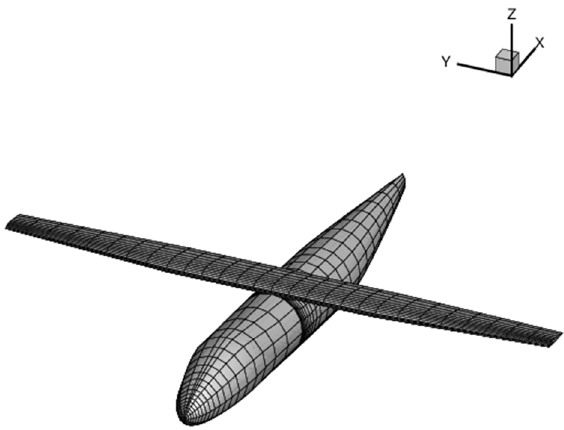
Figure 8. Airframe structured-surface meshing.